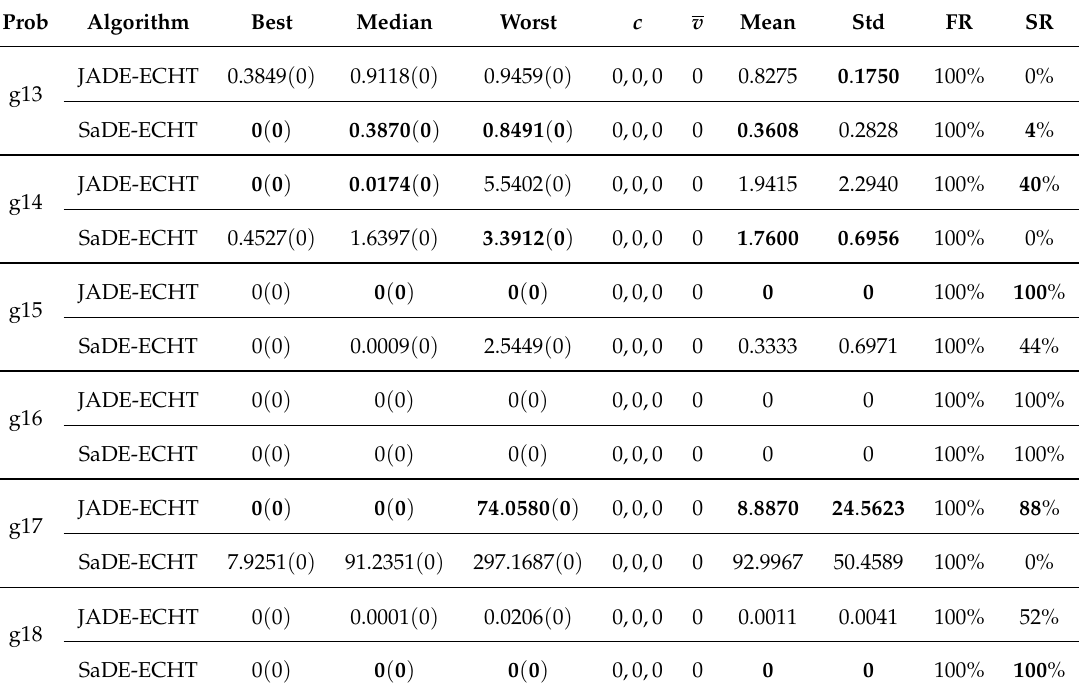
Table 5. Comparison of JADE-ECHT and SaDE-ECHT after FES = 500,000 for g13–g18. The bold numbers indicate the better